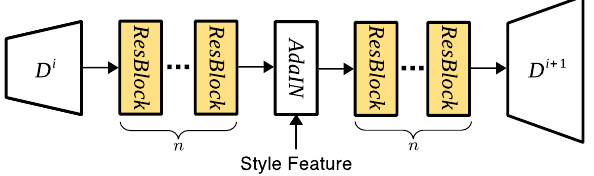
Figure 8. AdaIN with ResBlocks. n represents the number of ResBlocks.